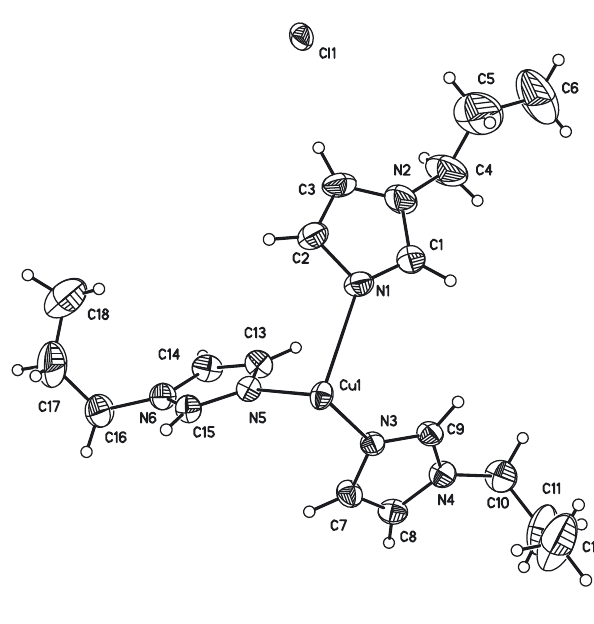
Table  : Data collection and